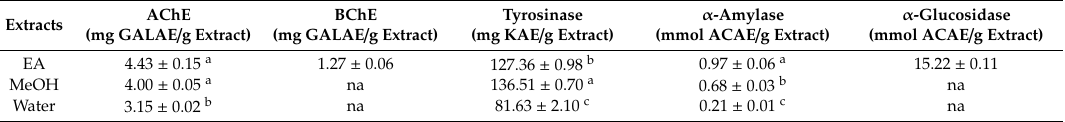
Table 7. Enzyme inhibitory properties of the tested